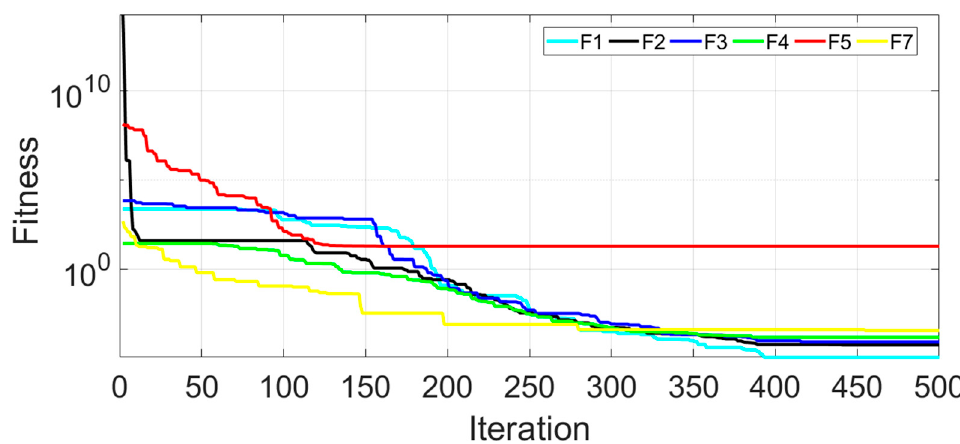
Figure 5. Convergence curves of the proposed Hybrid Modified Sine Cosine Algorithm Cuckoo Search Algorithm (HMSCACSA) using six mathematical functions. The MSCA, HMSCACSA, Particle Swarm Optimization–Artificial Bee Colony (PSOABC), Particle Swarm Optimization–Artificial Bee Colony (PSOGWO), and Particle Swarm Optimization–Gravitational Search Algorithm (PSOGSA) are presented as blue, green, cyan, black, and magenta smoothed lines,